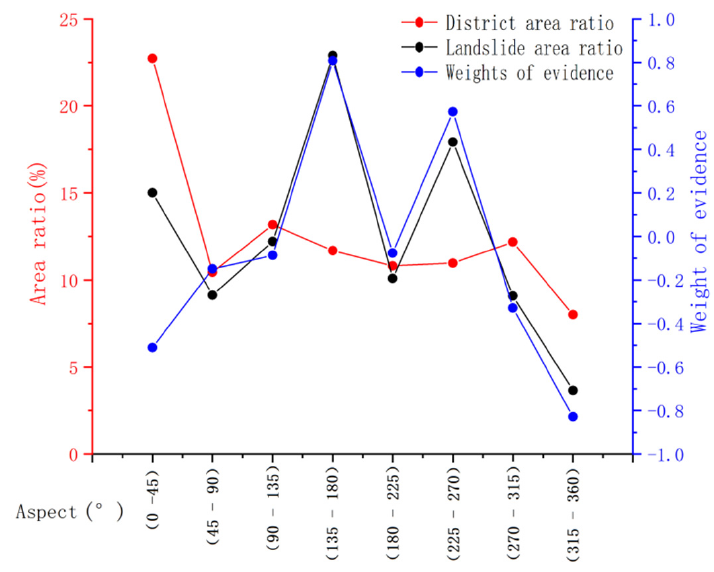
Figure 7. Aspect statistical analysis results.